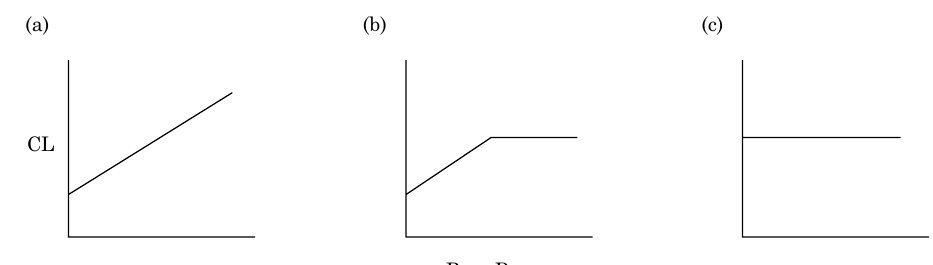
figure 1. relationship between the critical level (cL) of available p by the Mehlich-1 extractant and remaining p (rem-p) in soils of great loss of extraction capacity (a), of intermediate loss of extraction capacity (b), and without loss of extraction capacity (c). source: novais and smyth